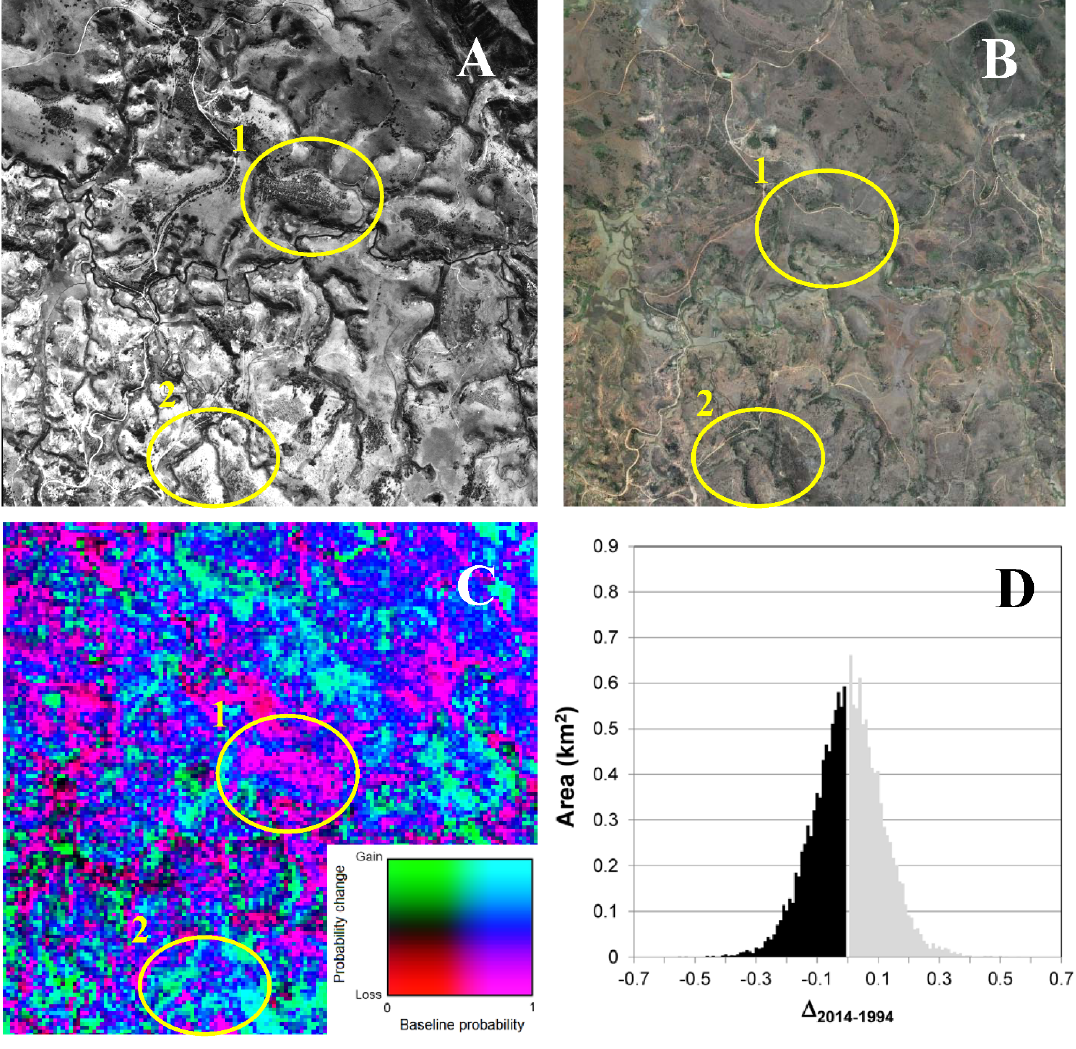
Figure 3. Dynamics of woody cover at Site 01, Ambongabe, near the town of Anjozorobe north of Antananarivo (18°19'S, 47°54'E). ( A ) Aerial photograph taken in 1992. ( B ) Digital Globe image taken in 2014. ( C ) Change map based on Landsat imagery (see Figure 2). ( D ) Histogram depicting the frequency distribution of the delta of woody cover probability values between 2014 and 1994 based on Landsat imagery. Woody cover loss is represented in black, while gain is represented in gray. Ellipses in (A–C) relate to particular woody cover dynamics described in the text. See Figure 1 for the geographic location of Site 01 within the study